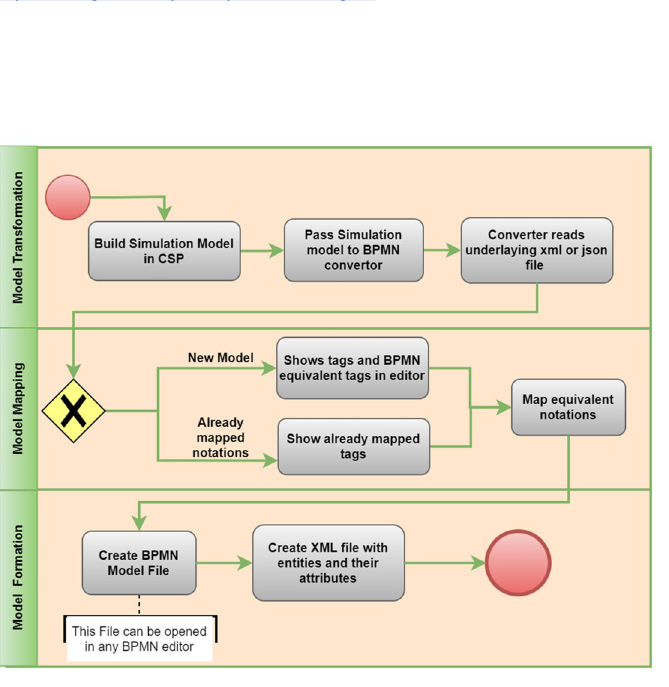
Fig 3. BPMN model showing the detail steps for all three steps. Model Transformation, Model mapping and Model formation.